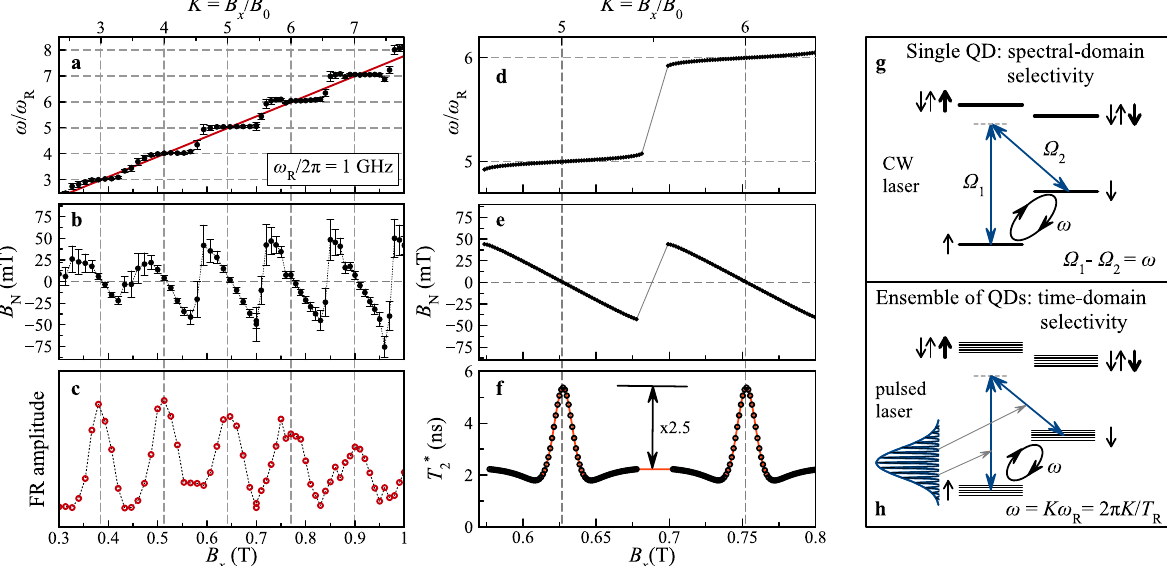
Fig. 2 Discretization of precession frequency by nuclear polarization. a Electron precession frequency in units of repetition frequency of the laser vs. external magnetic fi eld in absolute units (lower axis) and in units of B 0 = 128 mT (upper axis) - the black dots. Error bars give the frequency fi tting error with Eq. (3). Red line shows the electron precession frequency dependence on the magnetic fi eld without the contribution of nuclear spin polarization. b Overhauser- fi eld dependence on external magnetic fi eld. The dotted line is a guide to the eye. c Amplitude of the Faraday rotation signal measured vs. B x . The data in panels a - c are measured for a negative pump-probe spectral detuning: E Pu = 1.3839 eV and E Pr = 1.3864 eV. d Modeling of the frequency dependence on the external magnetic fi eld. Plateaus around the modes 5 and 6 are clearly observable. e Magnetic fi eld dependence of Overhauser- fi eld built up in the QDs for compensation of the external fi eld. f Variation of the spin dephasing time with external magnetic fi eld. The multiplication factor of 2.5 is expected based on the simulation parameters. g Schematics of the energy levels of a singly charged QD in Voigt geometry and the two lasers photon energies ℏ Ω 1 and ℏ Ω 2 , slightly detuned from the trion transitions, driving the Λ system for coherent population trapping. ω is the Larmor frequency. h Ensemble of singly charged QDs driven by a negatively detuned pulsed excitation in the Voigt geometry. The laser pulse can be represented as a frequency comb combining multiple CW frequencies that satisfy the CPT for QDs having different optical transition energies and g factors. We highlight a pair of CW laser components by gray arrows for one contributing QD. An alternative explanation is also given in the main